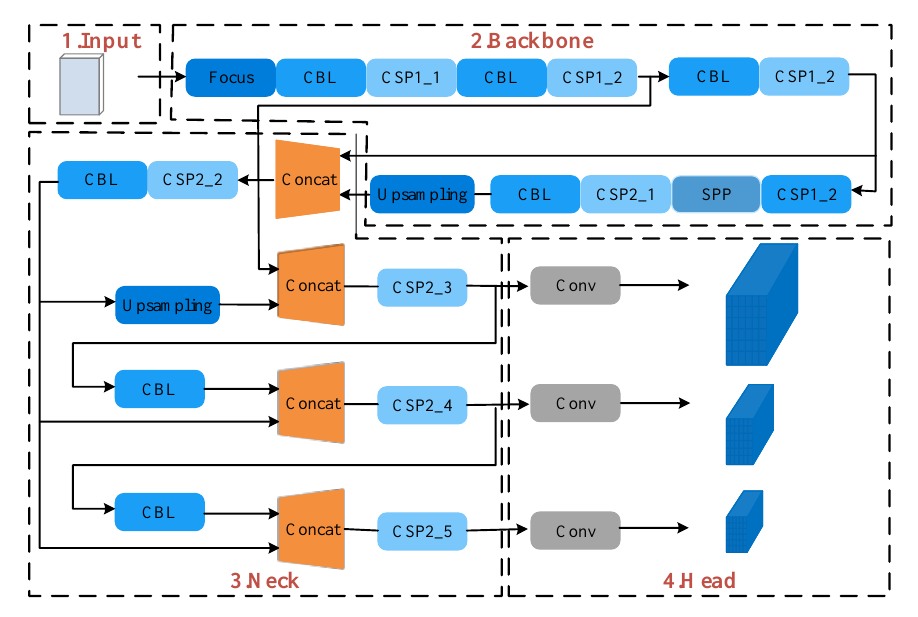
Figure 3. Position node recognition